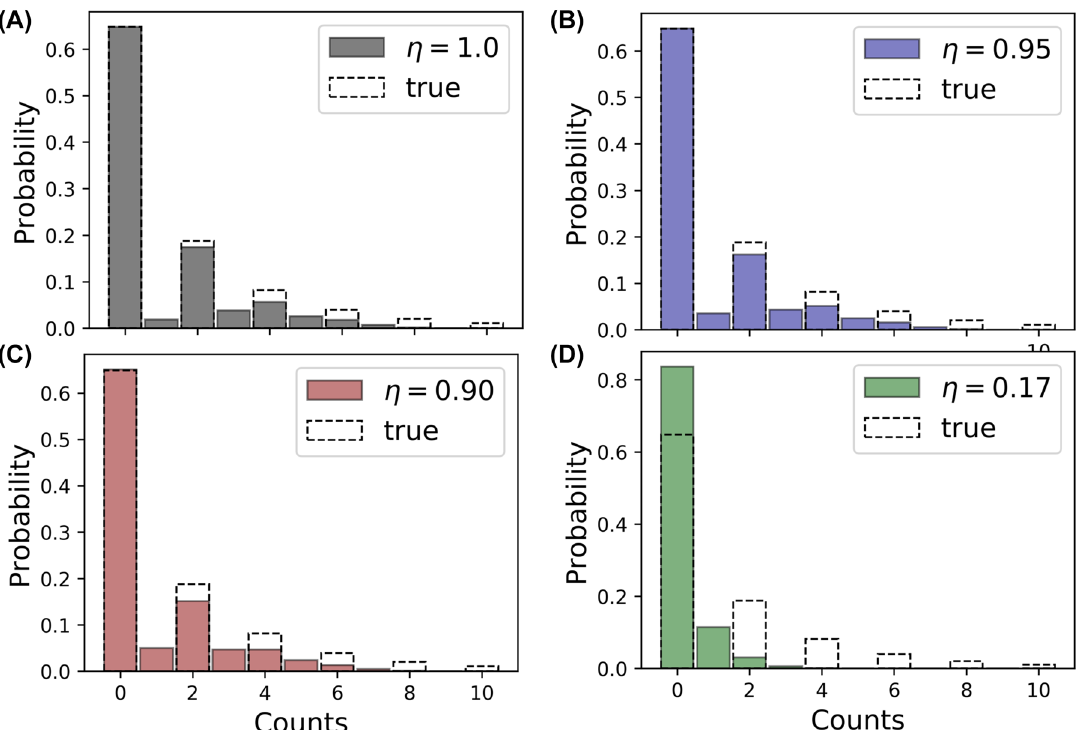
Figure 7: Measurement of photon statistics of the vacuum squeezed state (with the squeezing parameter 𝜉 = 1). Bar charts show the distribution of counts for incoherent detection with ten constituent detectors with the efficiency of 100% (A), 95% (B), 90% (C), and 17% (D). Dashed bars represent the true distribution. For incoherent detection with 17% efficient constituent detectors (D), the true distribution (dashed columns) is completely wiped in the measured distribution (green). For coherent detection with the same constituent detectors, the gray distribution in (A), close to the true distribution, holds.